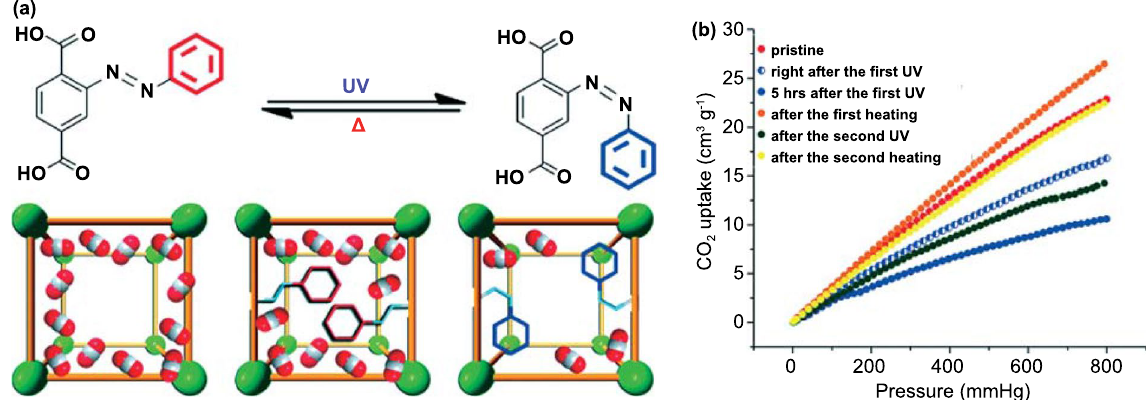
Fig. 14 a (Top) Trans -to- cis isomerization of the ligand of PCN-123 induced by UV irradiation and the cis -to- trans isomerization induced by heat treatment. (Bottom) Schematic illustration showing the suggested CO 2 uptake in MOF-5, PCN-123 trans , and PCN-123 cis . b CO 2 adsorp- tion isotherms (at 295 K) of PCN-123 showing reversible conformational change [133]